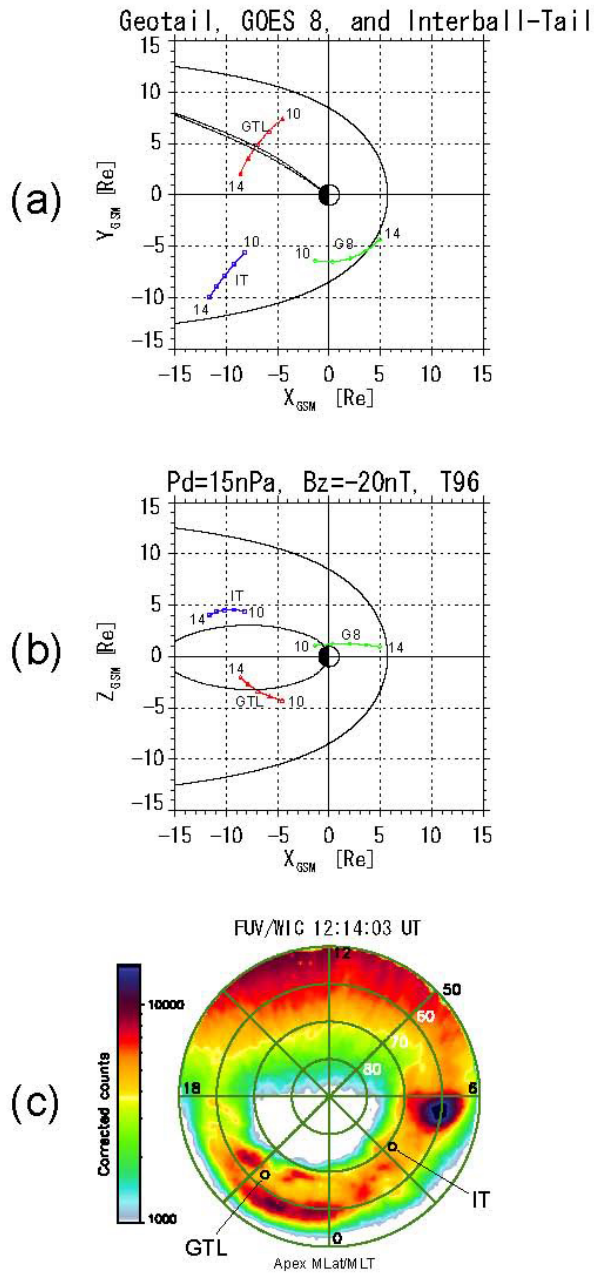
Fig. 2. Locations of the GOES-8, Geotail, and Interball-Tail during 10:00–14:00 UT on 5 October 2000, projected on the GSM (a) XY and (b) XZ plane. Magnetic field line by Tsyganenko T96 model (Tsyganenko, 1995) from the position of Geotail at 12:14 UT and the magnetopause model (Shue et al., 1997) are also shown for ref- erence. (c) The far-ultraviolet image from the IMAGE satellite. Footprints of Geotail and Interball-Tail are mapped with the T96 model.